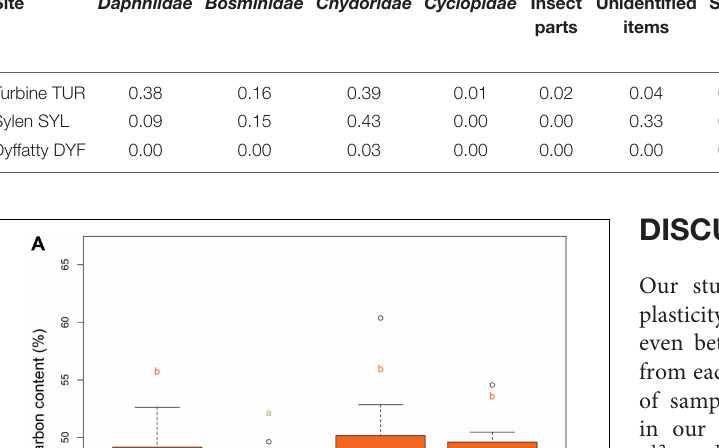
TABLE 2 | Diet of topmouth gudgeon based on stomach content analysis (% number). Site Daphniidae Bosminidae Chydoridae Cyclopidae Insect